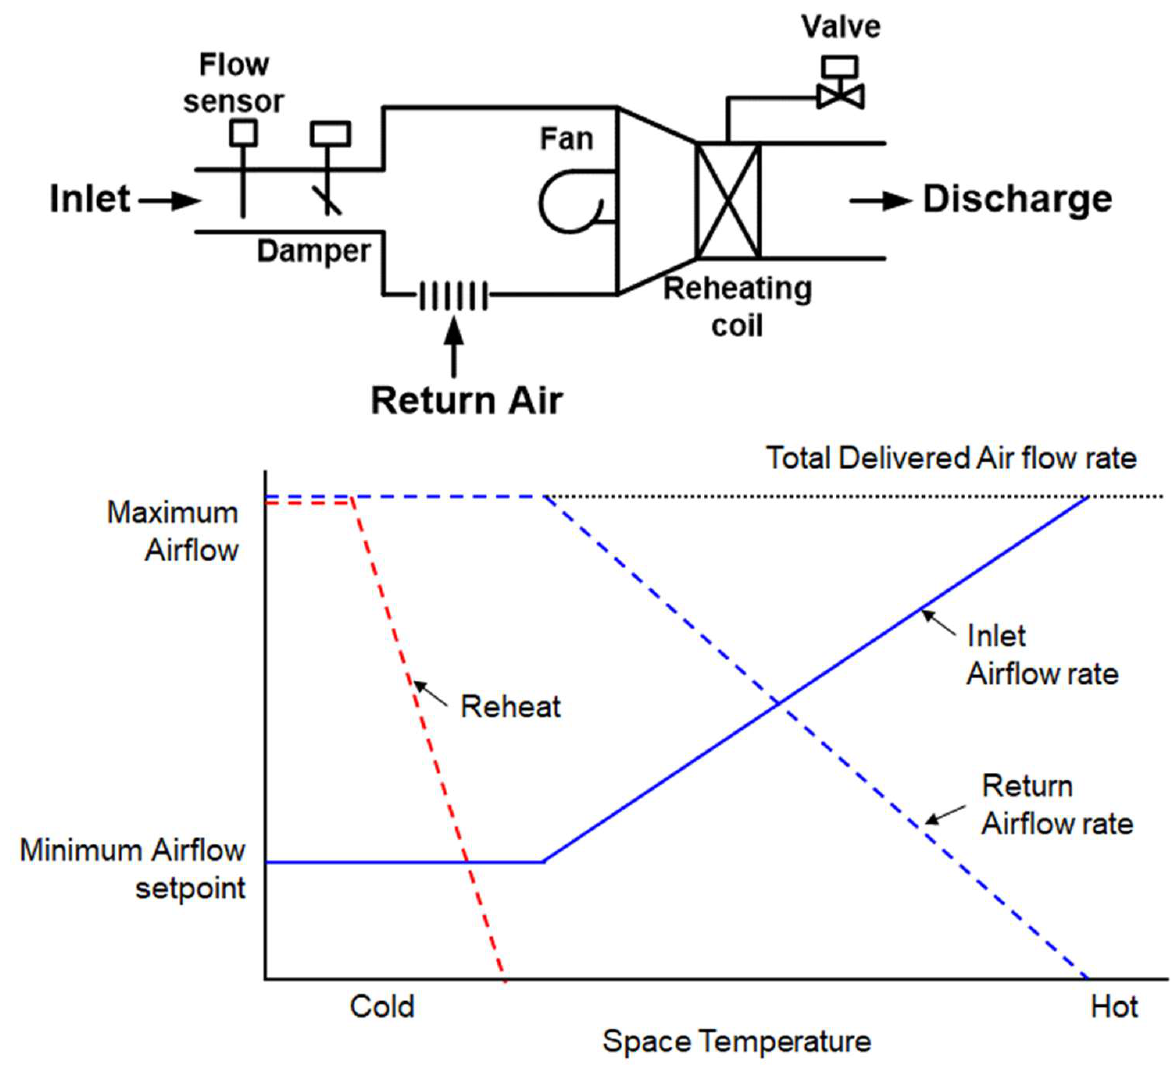
Figure 4. Series fan-powered VAV terminal unit and control sequence [16].